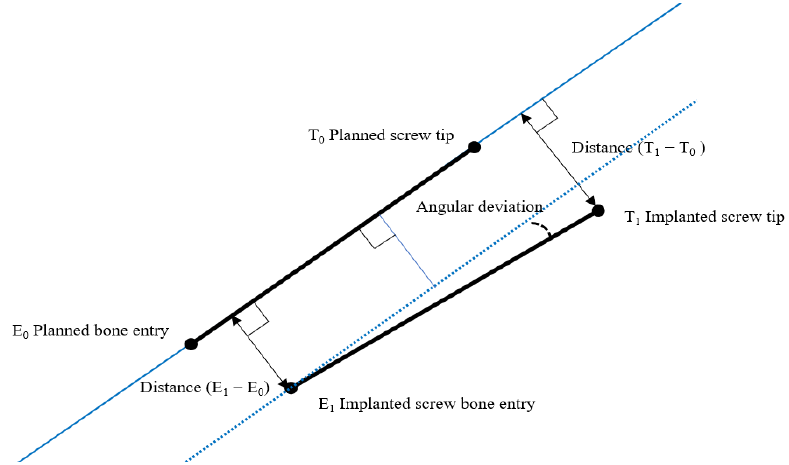
Figure 3. Overview of measurement model for technical